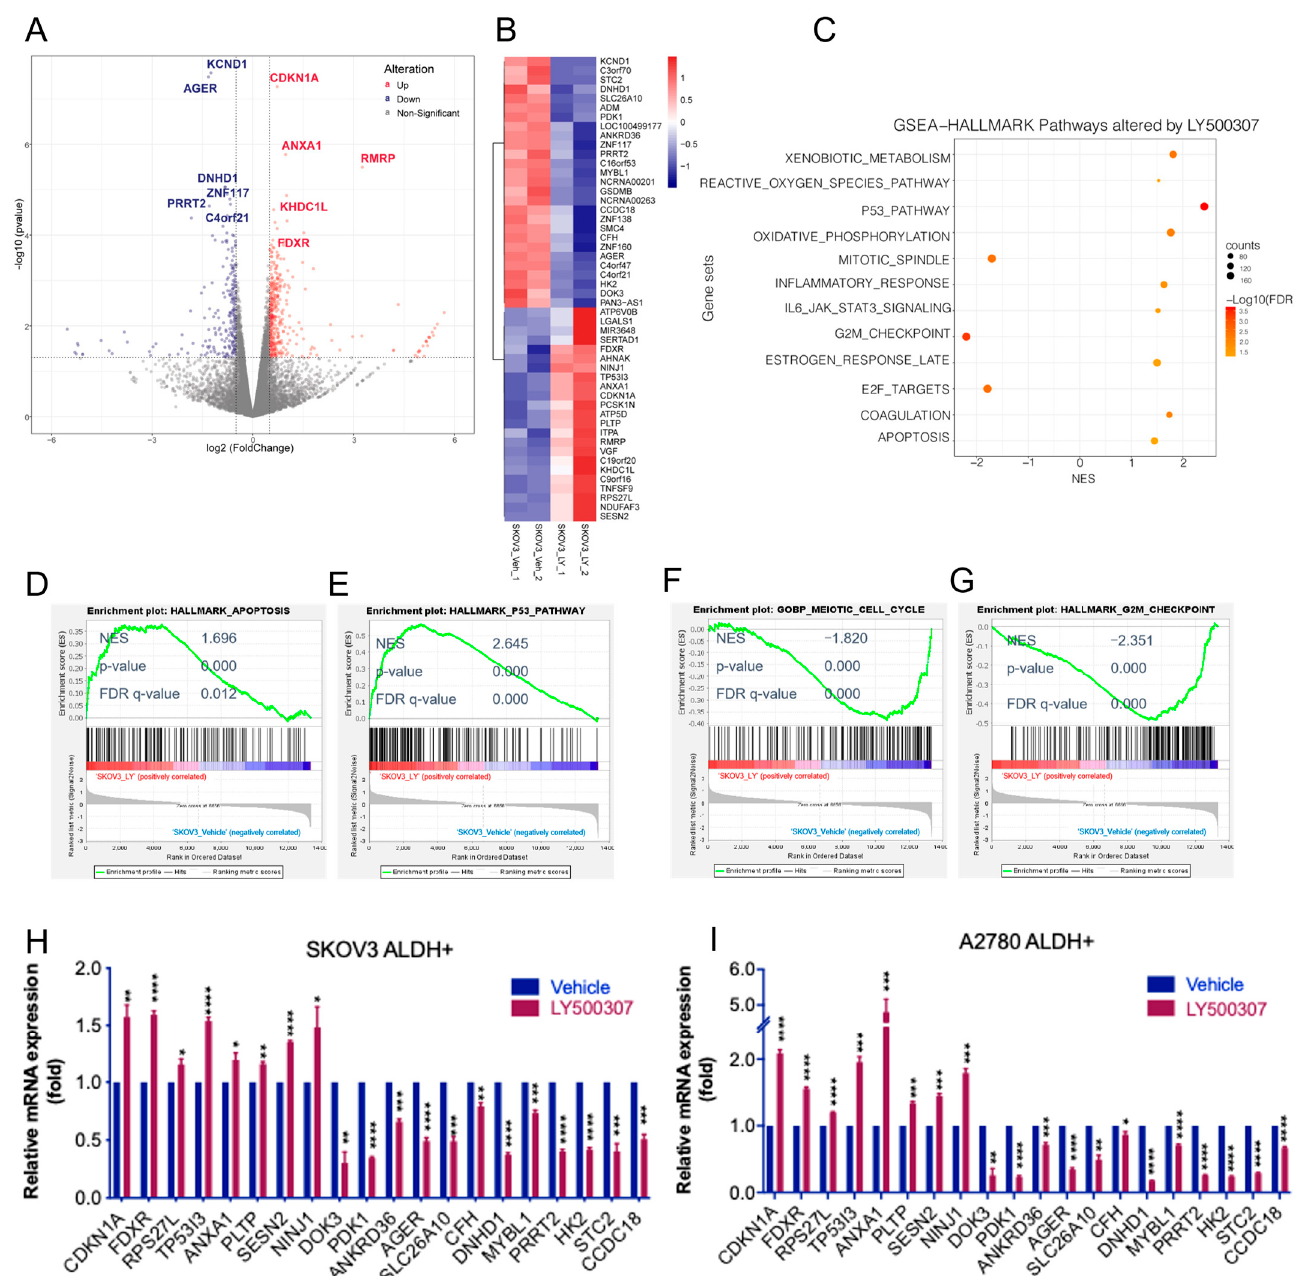
Figure 3. Identification of altered pathways following ER β agonist treatment using RNA seq analysis. SKOV3 ALDH+ve cells were treated with vehicle or LY500307 for 24 h, RNA was isolated and then subjected to RNA sequencing. ( A ) Volcano plots comparing gene expression levels for vehicle vs. LY500307 treated OCSCs. Counts values were normalized with DESeq2, X-axis showed the Log2 fold change of gene expression levels between groups, and Y-axis indicates -log10( p -value). Significantly upregulated or downregulated genes were marked in red and blue, respectively, with the criteria of p < 0.05 and |log2(fold change)| > 0.5. The top 10 DEGs, including CDKN1A and FDXR, are labeled. ( B ) Heatmap showing top up- and downregulated DEGs. ( C ) Bubble plot of top GSEA hallmark gene set enrichment results. Y-axis showed the gene set names; X-axis indicated the normalized enrichment scores (NES). Positive NES indicates gene set enrichment in LY500307 treated group, while negative NES indicates gene set enrichment in Vehicle treated group. Dot size indicates the gene number enriched. Color demonstrates –log10(FDR), showing the significance of enrichment. ( D – G ) GSEA of LY500307 modulated genes shows correlation with signatures of apoptosis,